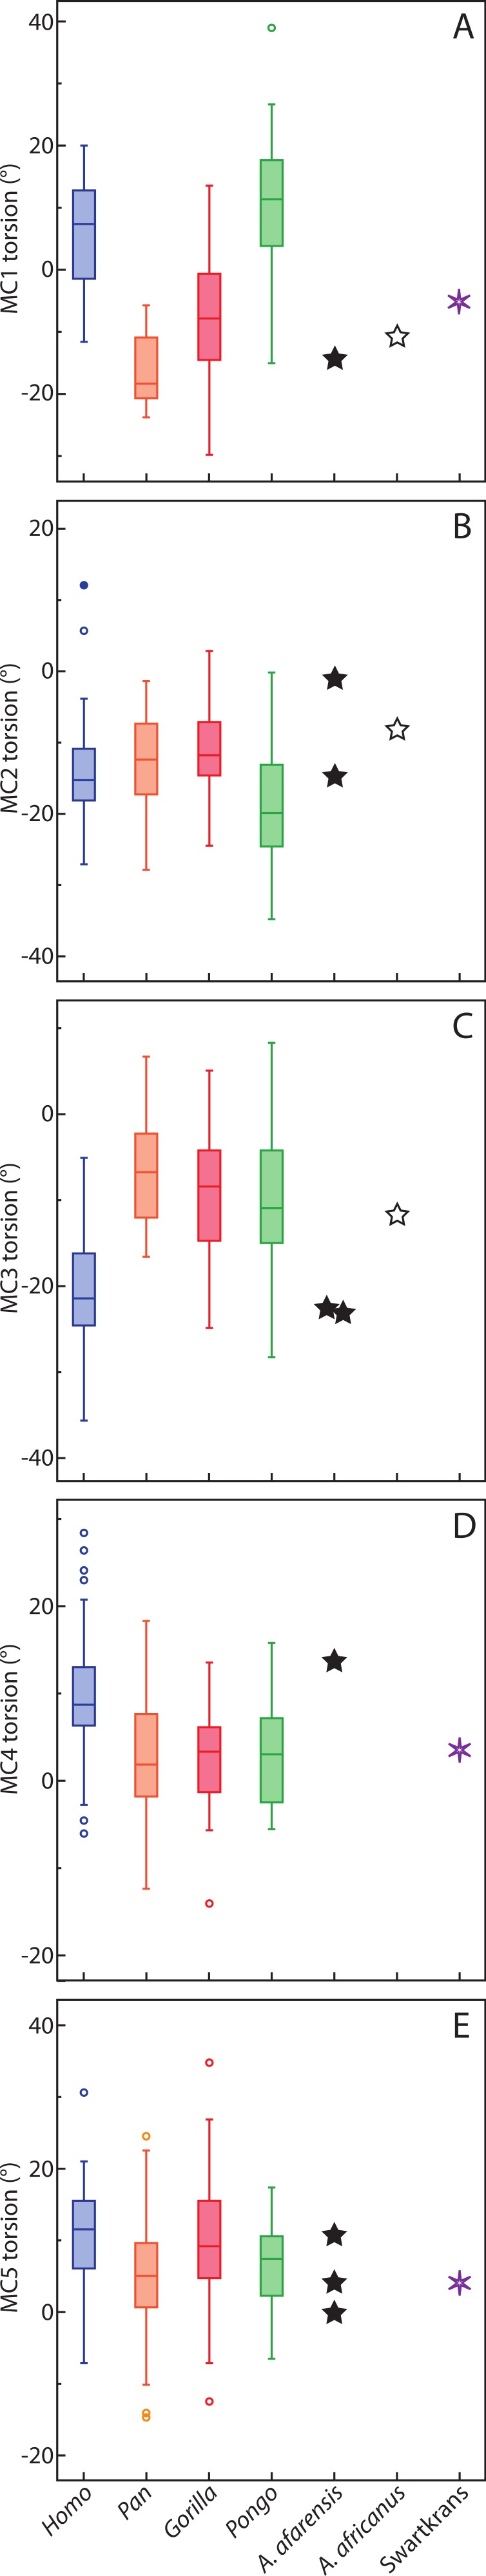
Boxplot of metacarpal torsion.Boxplot of the torsion of MC1 to MC5. The box represent the 25–75 quartiles, the horizontal line the median, the whiskers the range, and open and close circles represent outliers and extreme outliers (more than 1.5 and 3.0 standard deviation from the mean).